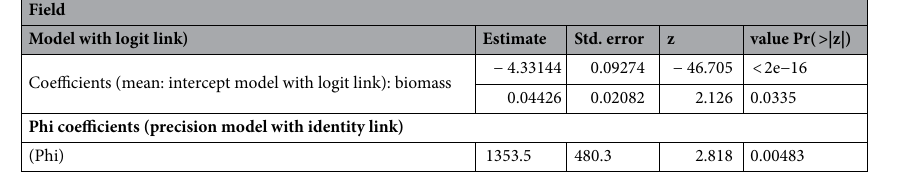
Table 1. Summary of estimates of model coefficients CO 2 = f(biomass)—field. Laboratory: Log-likelihood: 155.3 on 3 Df, Pseudo R 2 : 0.01306; Field: Log-likelihood: 68.98 on 3 Df, Pseudo R 2 : 0.2073.